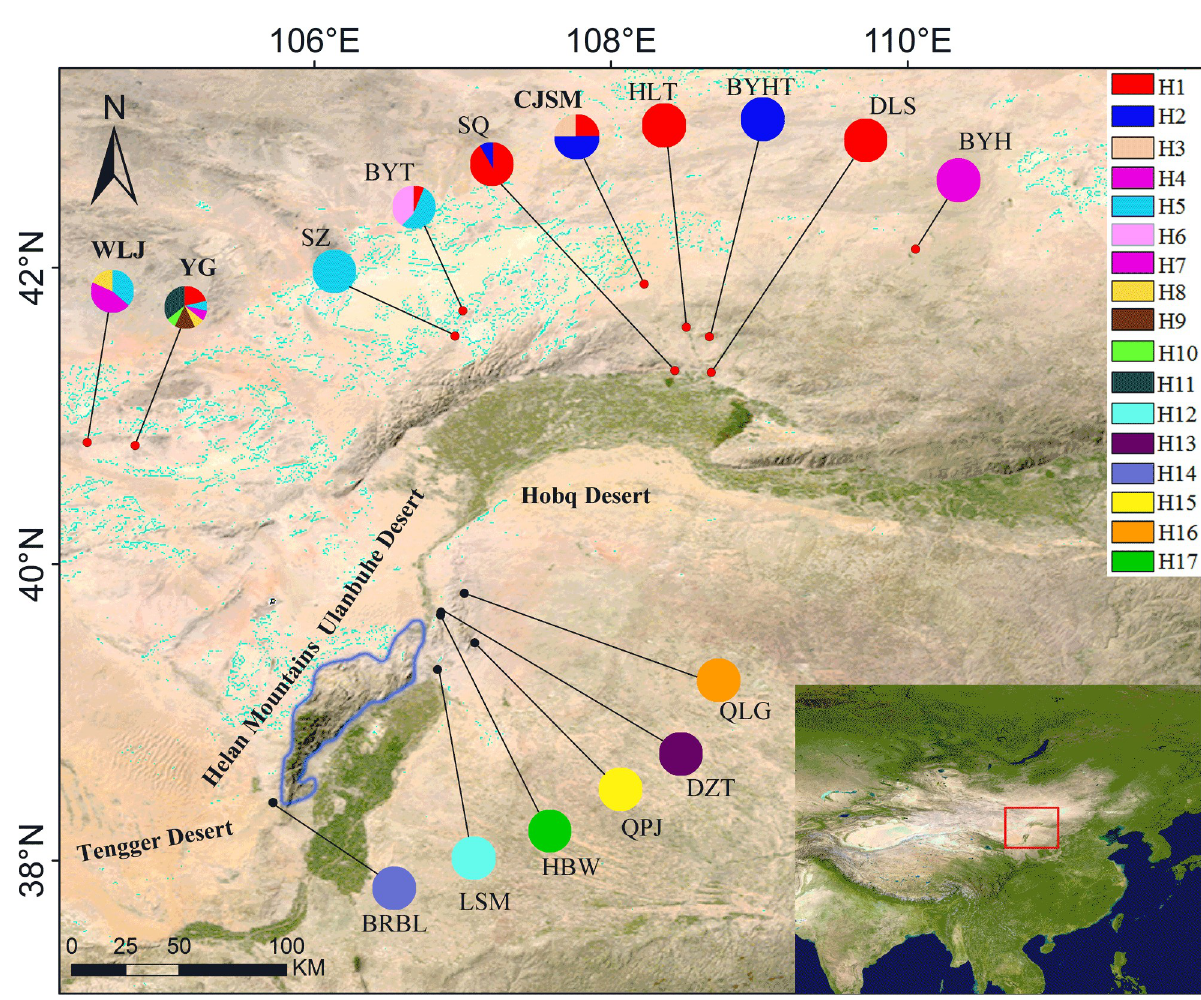
Fig 2. Geographic distribution of 17 cpDNA haplotypes detected in 16 populations of Tugarinovia mongolica from Inner Mongolia. Pie charts show the frequency of haplotype in each population. Red dots represent the population of the northern group (NG), and black dots represent the population of the southern group (SG). The blue line outlines represent the location of Helan Mountain. The nomenclature of NG and SG populations (See Table 1) is: HLT, Hailiutu; DLS, Delingshan; CJSM, Chuanjinsumu; BYH, Bayinhua; BYHT, Bayinhatai; SQ, Shuiquan; SZ, Saizhen; BYT, Bayintu; WLJ, Wuliji; YG, Yingen; LSM, Lashenmiao; DZT, Dizhentai; BRBL, Barunbieli; QPJ, Qipanjing; QLG, Qianligou; HBW, Haibowan.